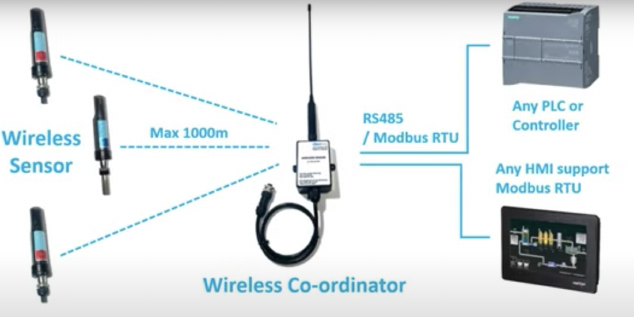
Figure 4. The establishment of wireless sensor networks Set-up, (accessed on 14 September